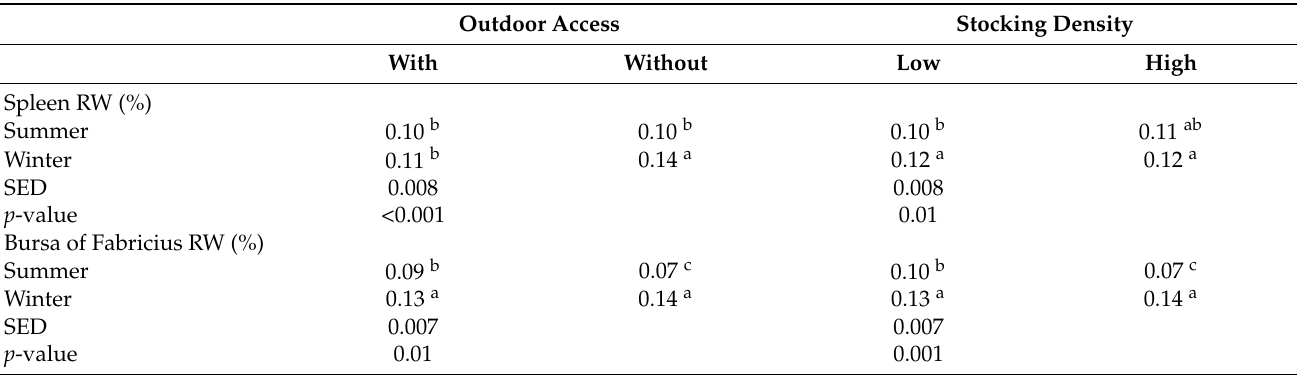
Table 10. Effects of season × system and season × density interactions on the relative weight of lymphoid organs of Cobb500 broilers.